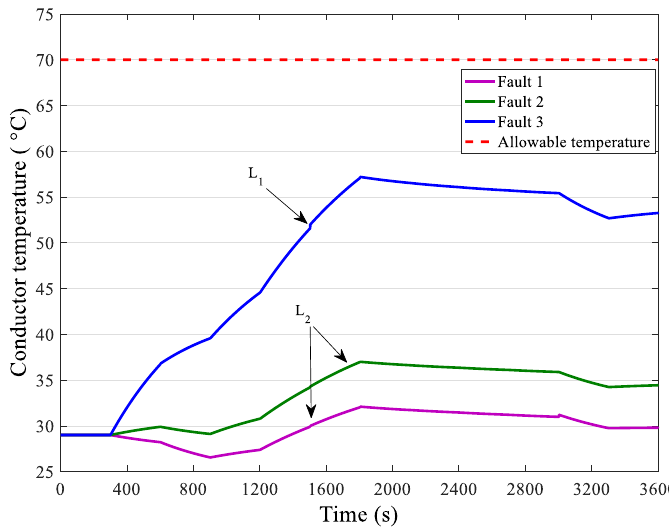
Figure 14. Change of conductor temperature after fault (winter).